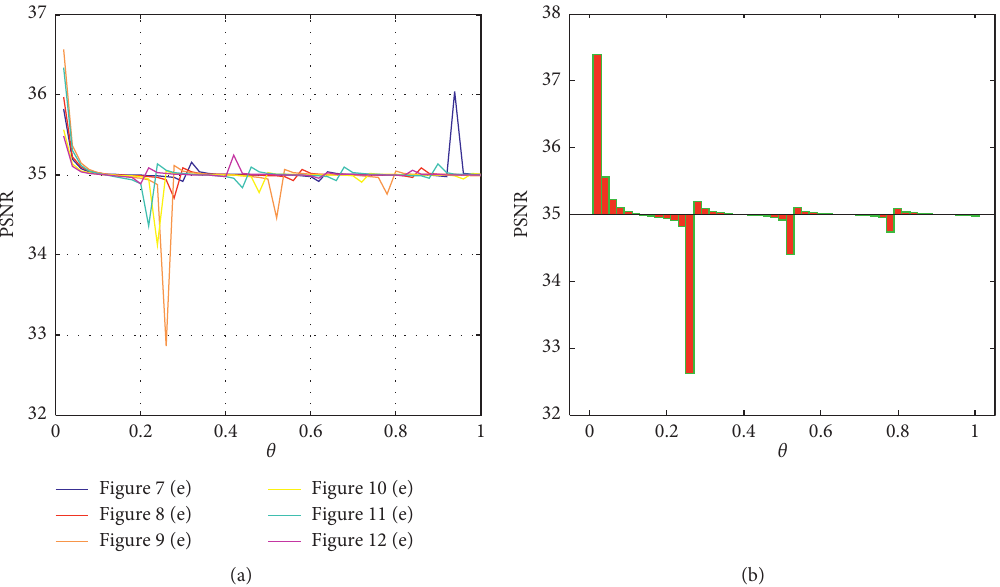
Figure 13: Schematic diagram of PSNR of repair results under different θ values. (a) PSNR when θ takes different values. (b) Average PSNR when θ takes different values.